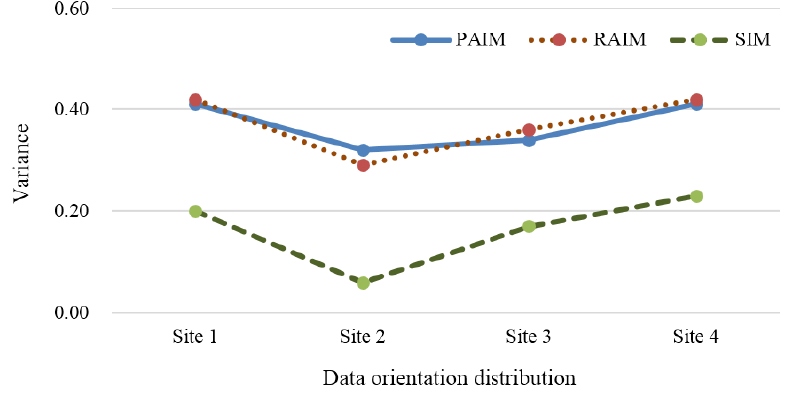
Figure 12. Comparison of data orientation distribution.